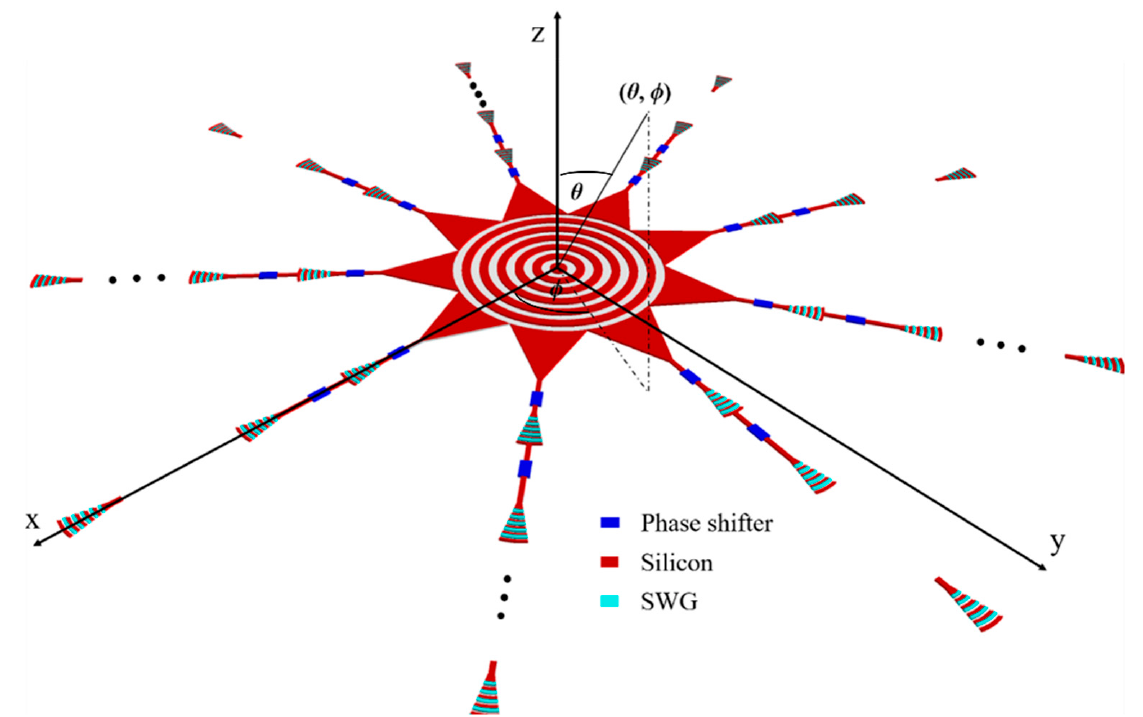
Figure 1. Schematic view of a circular optical phased array with radially arranged nano-antennas. Here, the SWGs are the subwavelength grating engineered nano-antennas, and θ and φ are elevation and azimuthal angles.